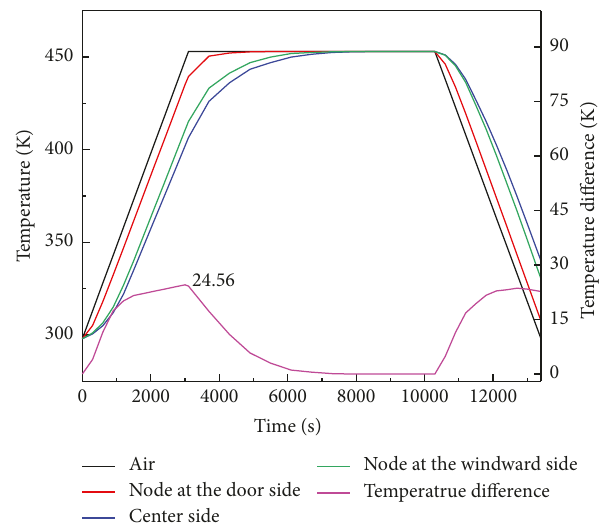
Figure 8: Temperature curve of the characteristic